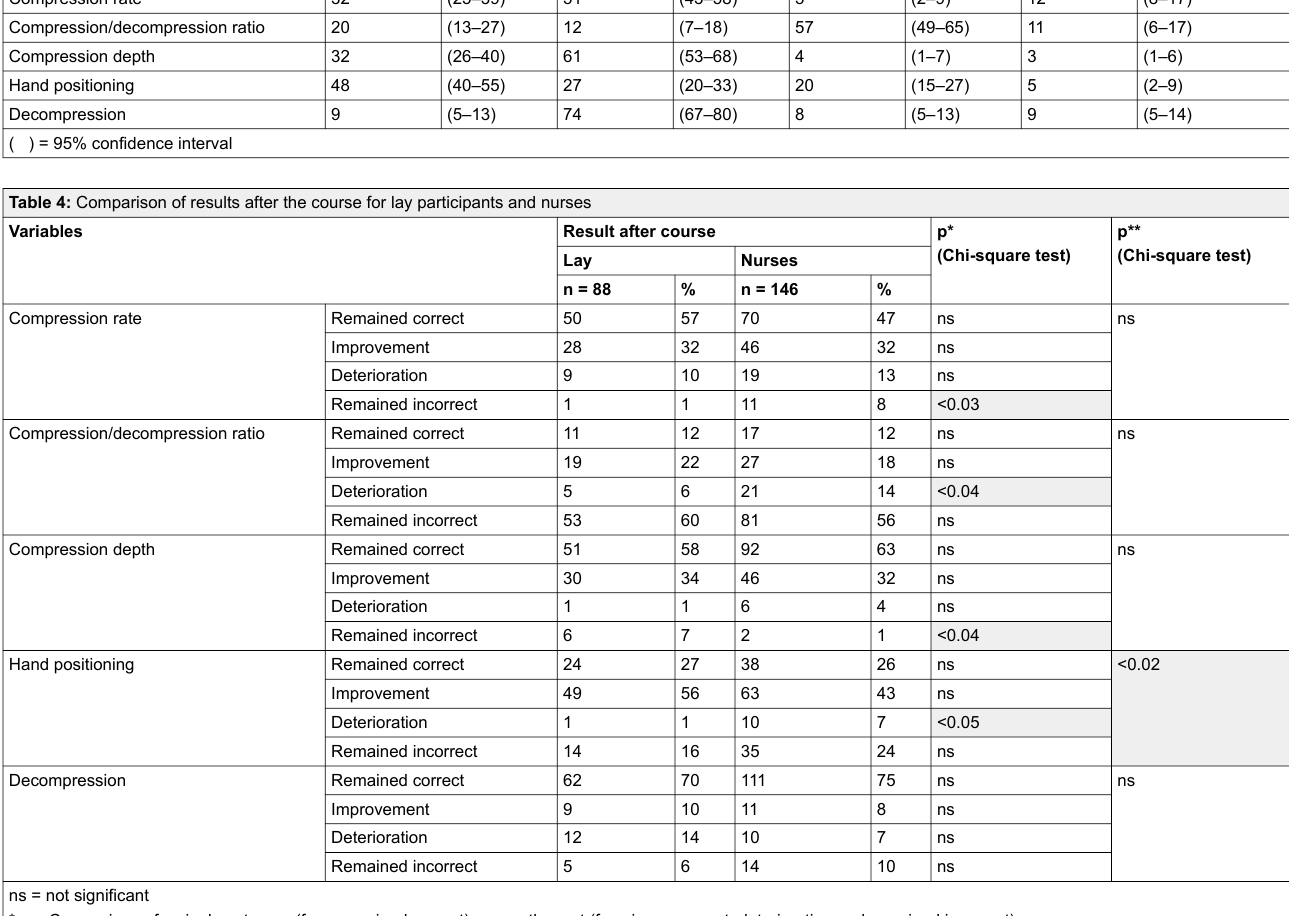
Compression depth